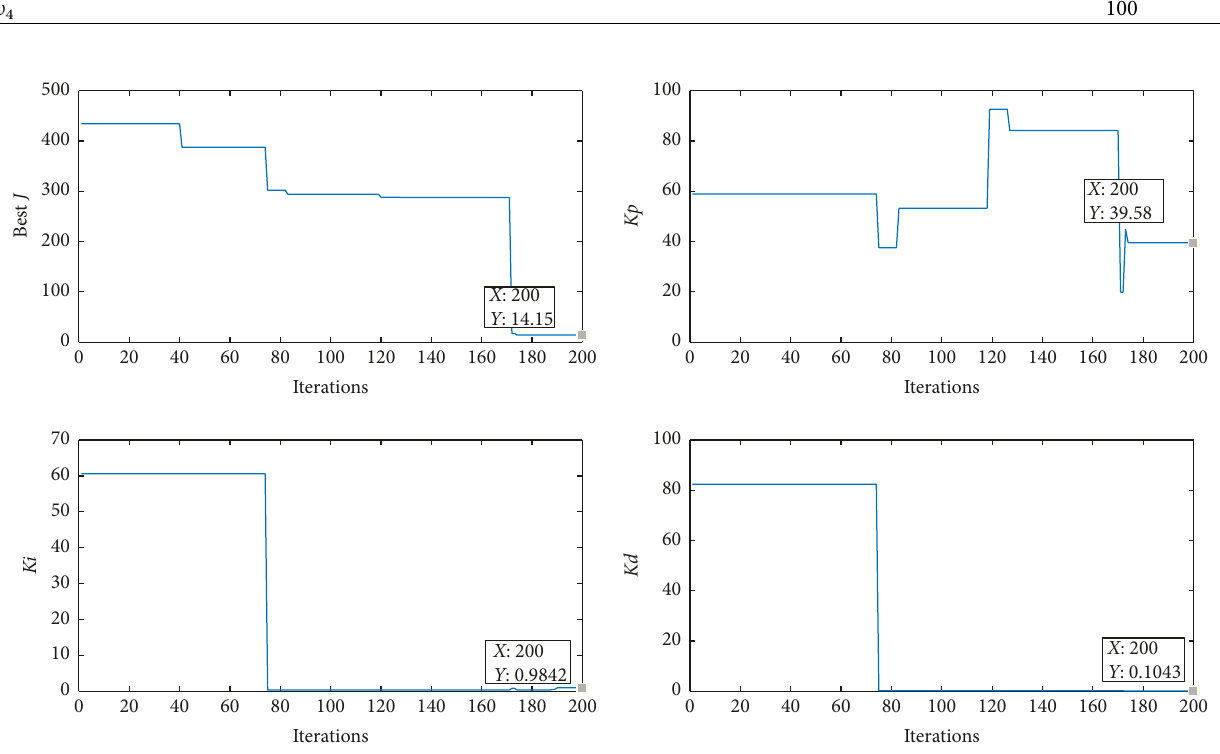
Figure 13: The optimizing process of wave compensation system after the pole